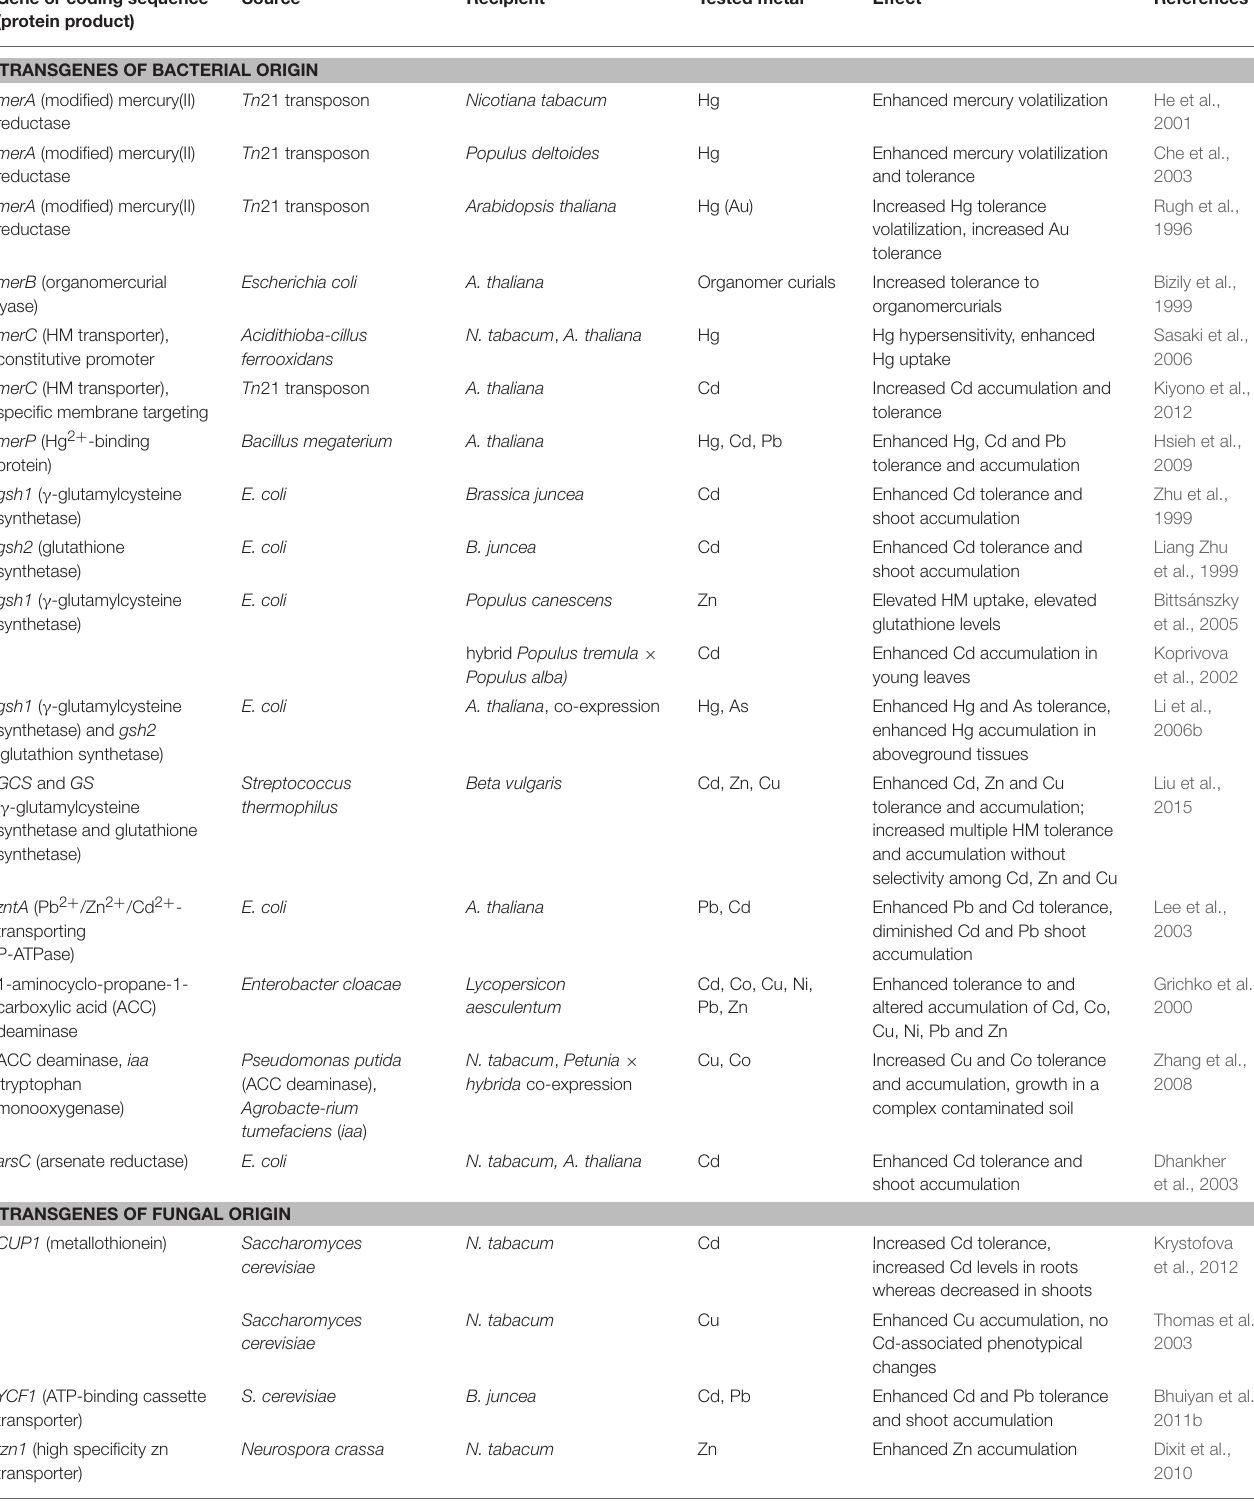
TABLE 2 | Exemplary studies dealing with GM plants with altered HM tolerance and/or accumulation ability. Gene or coding sequence (protein